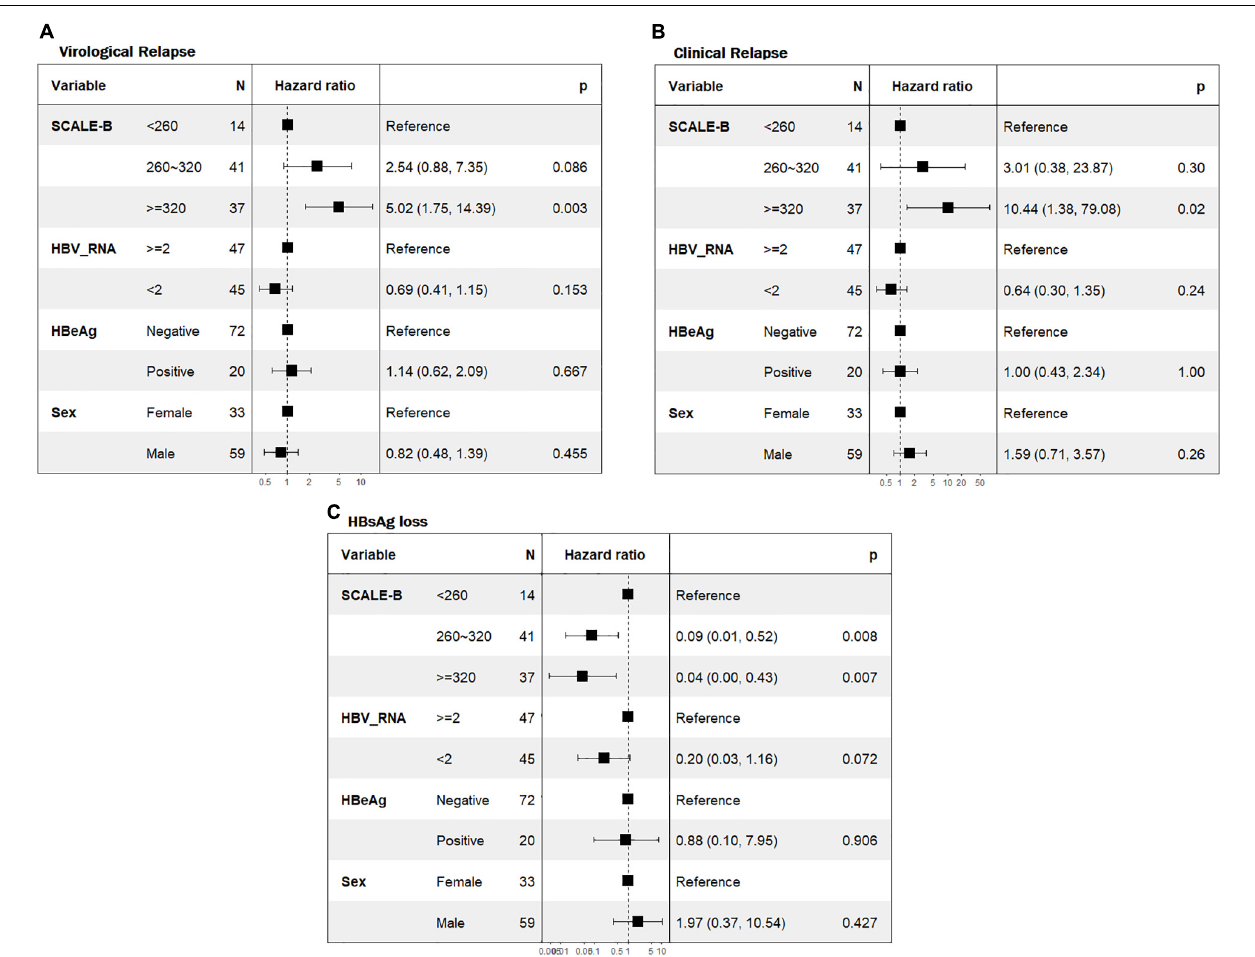
FIGURE 3 | Forest plot of the multivariate Cox regression analyses for predicting virological relapse, CR, and HBsAg loss. (A) VR, (B) CR, and (C) HBsAg loss. SCALE-B scores were calculated as HBsAg (log 10 IU/ml) + 20 × HBcrAg (log 10 U/ml) + 2 × age (year) + ALT (U/L) + 40 for the use of tenofovir, where HBsAg level (S), HBcrAg (C), age (A), ALT (L), and tenofovir (E) use for HBV (B) treatment. Adjusted hazard ratios of patients with pretreatment HBeAg status, EOT HBV RNA level, and SCALE-B score. HBeAg, hepatitis B e-antigen; HBV RNA, hepatitis B virus ribonucleic